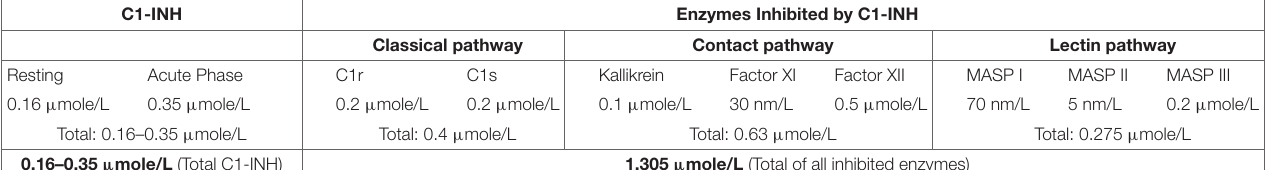
TABLE 1 | Stoichiometry of C1-inhibitor and the enzymes it inhibits. C1-INH Enzymes Inhibited by C1-INH Classical pathway Contact pathway Lectin pathway Resting Acute Phase C1r C1s Kallikrein Factor XI Factor XII MASP I MASP II MASP III 0.35 µ mole/L 0.2 µ mole/L 0.2 µ mole/L 0.1 µ mole/L 30